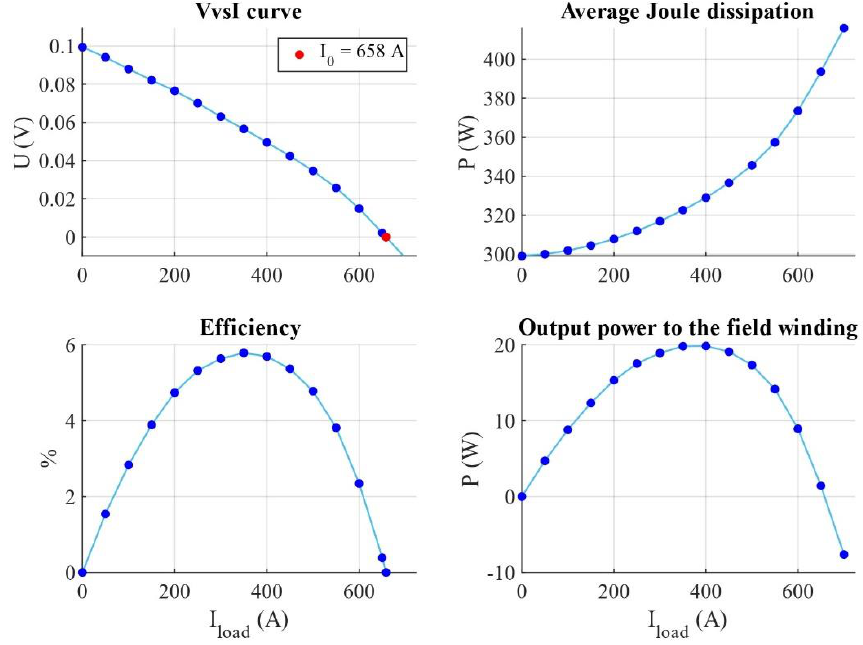
Figure 6. V vs. I relation, power dissipated vs. I load , efficiency vs. I load and power delivered to the field winding vs. I load of the dynamo flux pump.